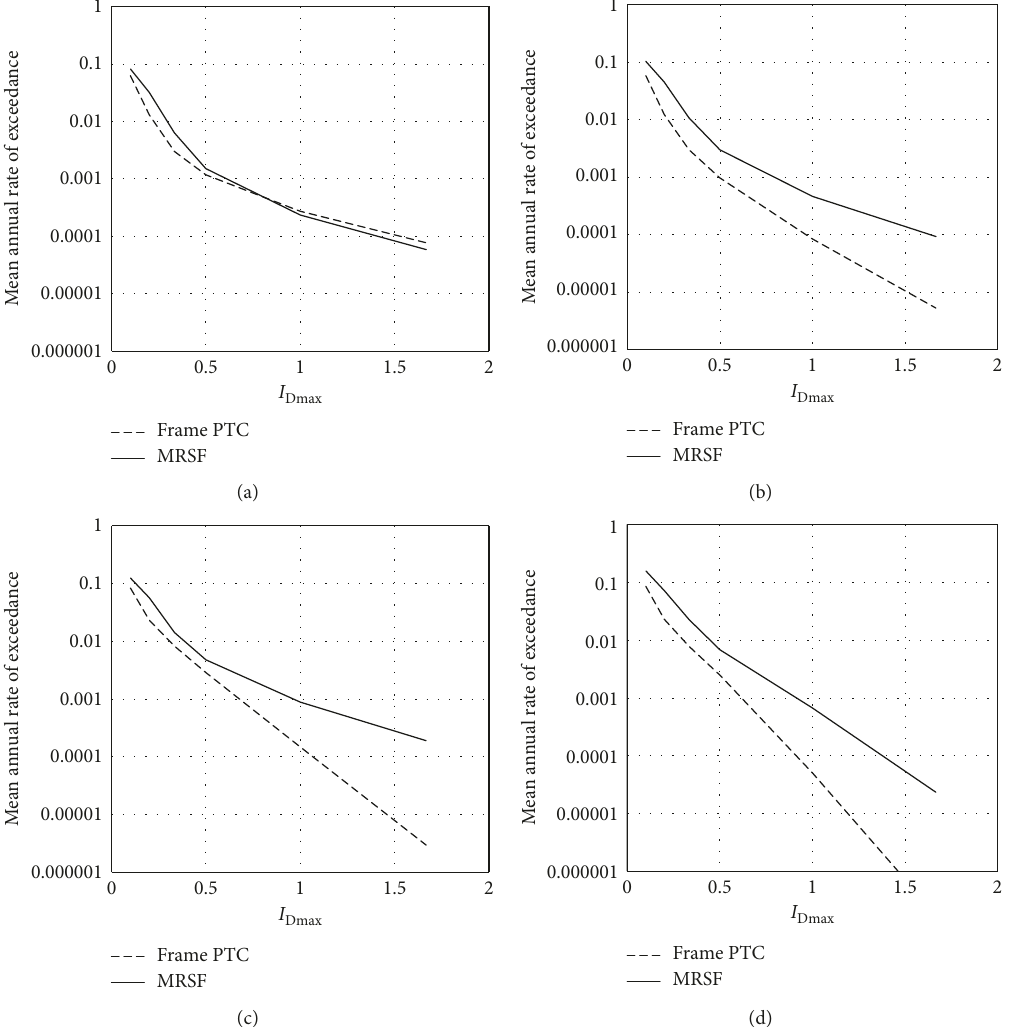
Figure 6: Comparison of the I